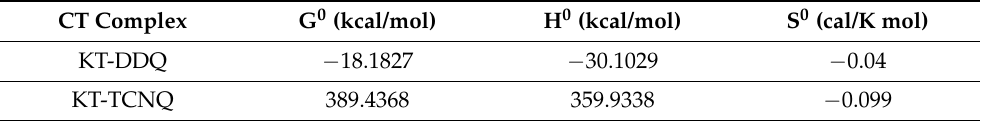
Table 6. The statistical thermodynamic calculation for the KT-DDQ and KT-TCNQ